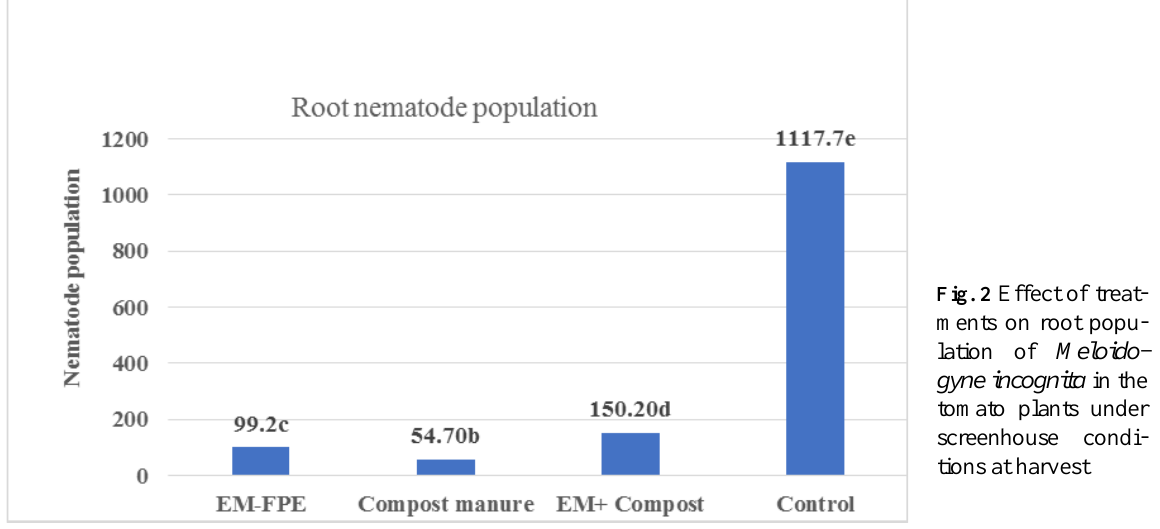
Fig. 2 Effect of treat- ments on root popu- lation of Meloido- gyne incognita in the tomato plants under screenhouse condi- tions at